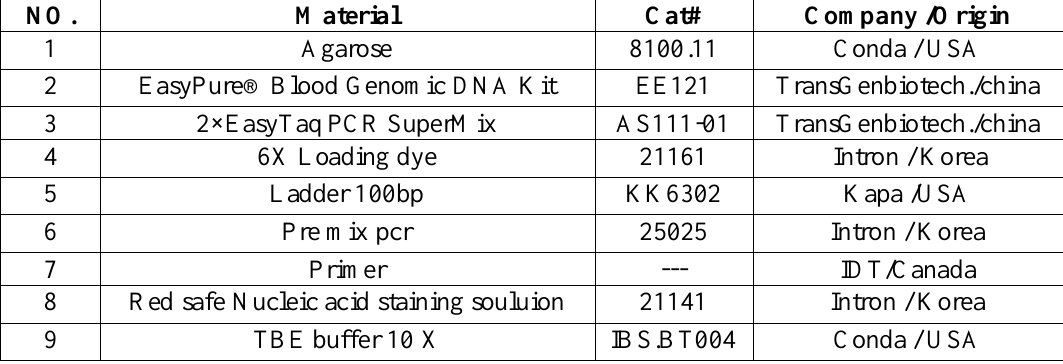
Table 2: The chemicals and kits used in this